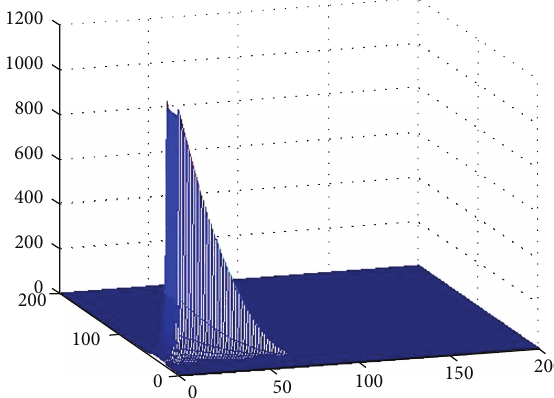
Figure 8: Resulting repulsive potential field in the blocked corridor